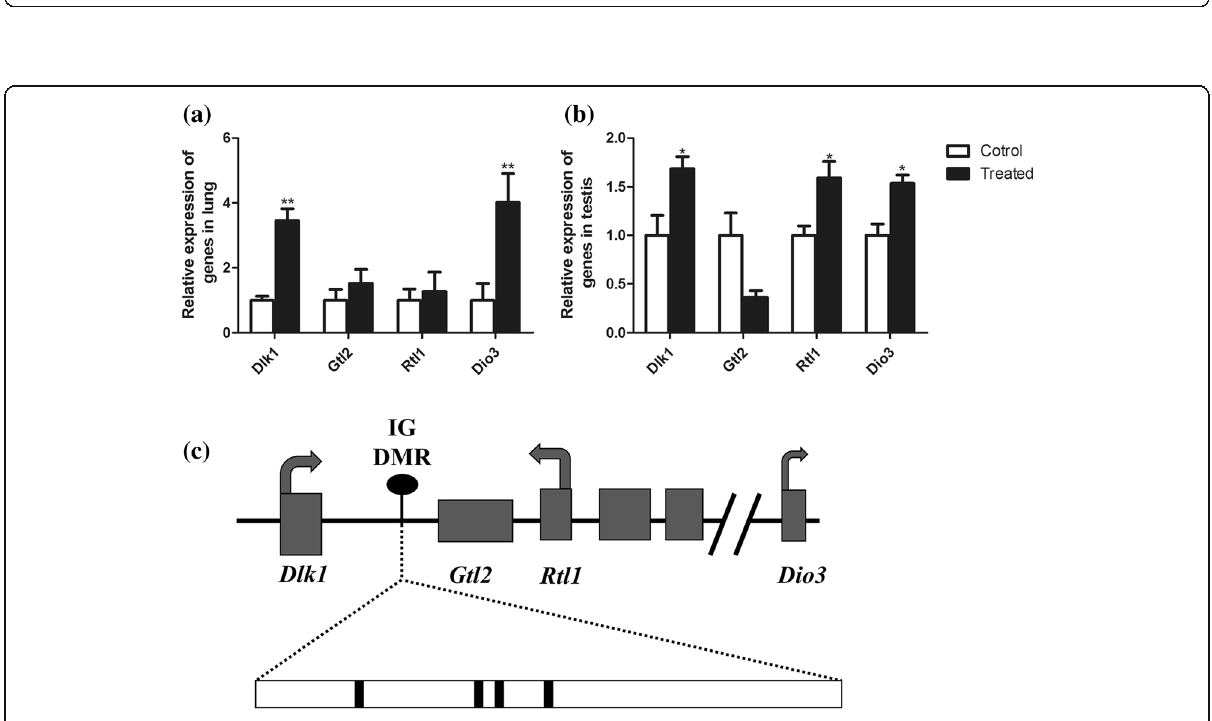
Fig. 4 The expression of Dlk1/Dio3 imprinted region. a The Dlk1/Dio3 region genes expressed in the lung. b The Dlk1/Dio3 region genes expressed in the testis. c Schema of the Dlk1/Dio3 region. * P < 0.05. ** P < 0.01. Student ’ s t